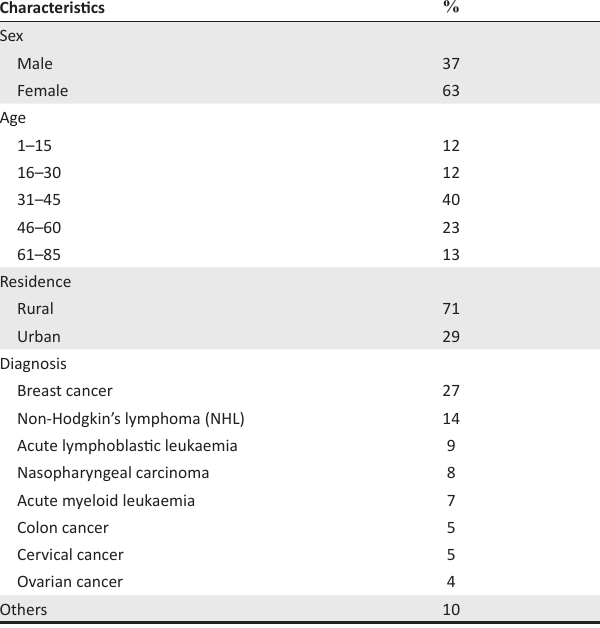
TABLE 1: Patient characteristics ( N = 100).